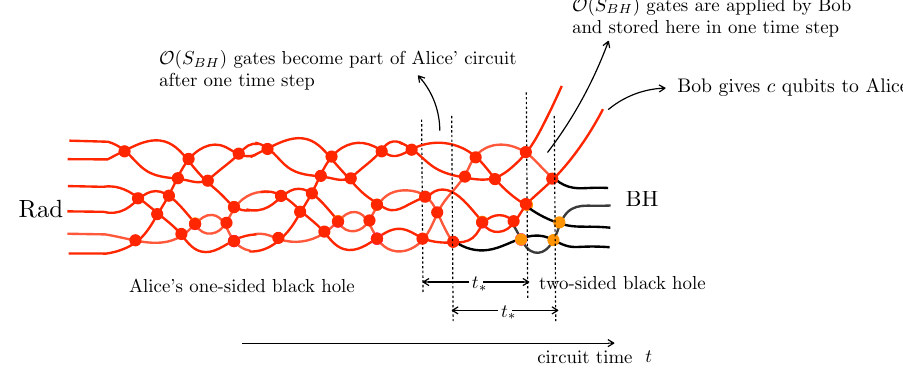
Figure 12 . The growth of the part of the quantum circuit belonging to the radiation.